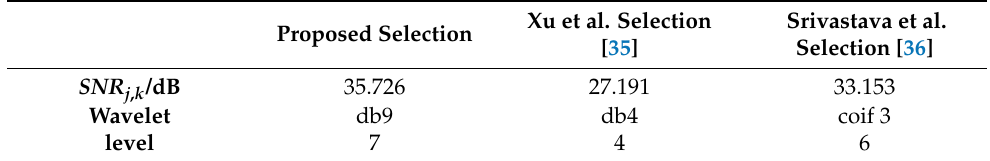
Table 9. The table for the comparison of the SNR j , k performance between the Xu et al., Srivastava et al., and proposed